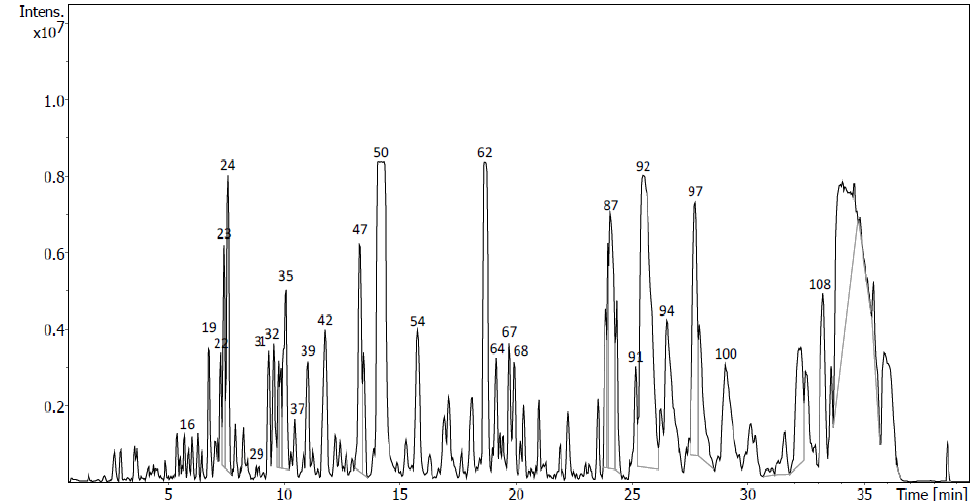
Figure 7. UHPLC-QToF chromatogram of sub-fraction D8 of U. gallii . Table 4. Flavonoids identified in targeted analysis via UHPLC-ESI-QToF of sub-fraction D8 of U. gallii (Rt = retention time, m/z = mass/charge ratio of the compound, mSigma = deviation in the isotopic pattern, Δ m/z = deviation in the mass ratio/charge measured in relation to the expected value).